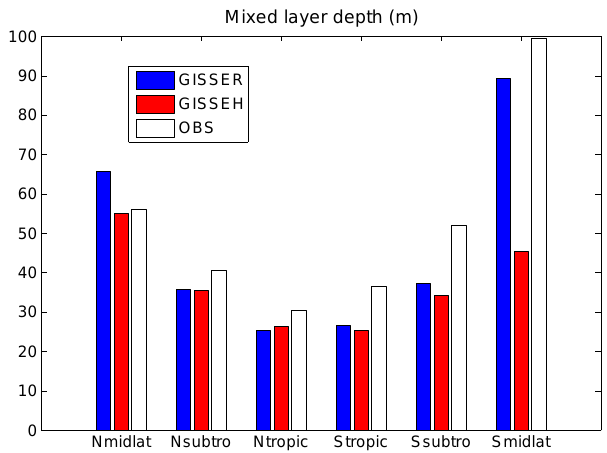
Fig. 1. Annual mean mixed layer depth comparison in the models and the observations in different regions (zonal averages). The Northern mid-latitude region (Nmidlat) extends from 40 ◦ N to the pole, the Northern subtropical region (Nsubtro) extends from 15 ◦ N to 40 ◦ N, the Northern tropical region (Ntropic) extends from the equator to 15 ◦ N, the Southern tropical region (Stropic) extends from the equator to 15 ◦ S, the Southern subtropical region (Ssubtro) extends from 15 ◦ S to 40 ◦ S and the Southern mid-latitude region (Smidlat) extends from 40 ◦ S to the Antarctic coast. The observations come from the deBoyer atlas (deBoyer Mont´egut et al., 2004). The units of the vertical axis are in meters. in both models (Fig. 2 therein) which, compounded by overestimated heat losees in the winter and cloud coverage during summer, lead to shallower mixed layer depths. Below 100 m and down to 3000 m (Fig. 2, GISSER exhibits significant warm bias whereas GIS- SEH is in better agreement with the observations. The GISSER deep warm bias is due to significant 240 eddy transport in the Southern Ocean.